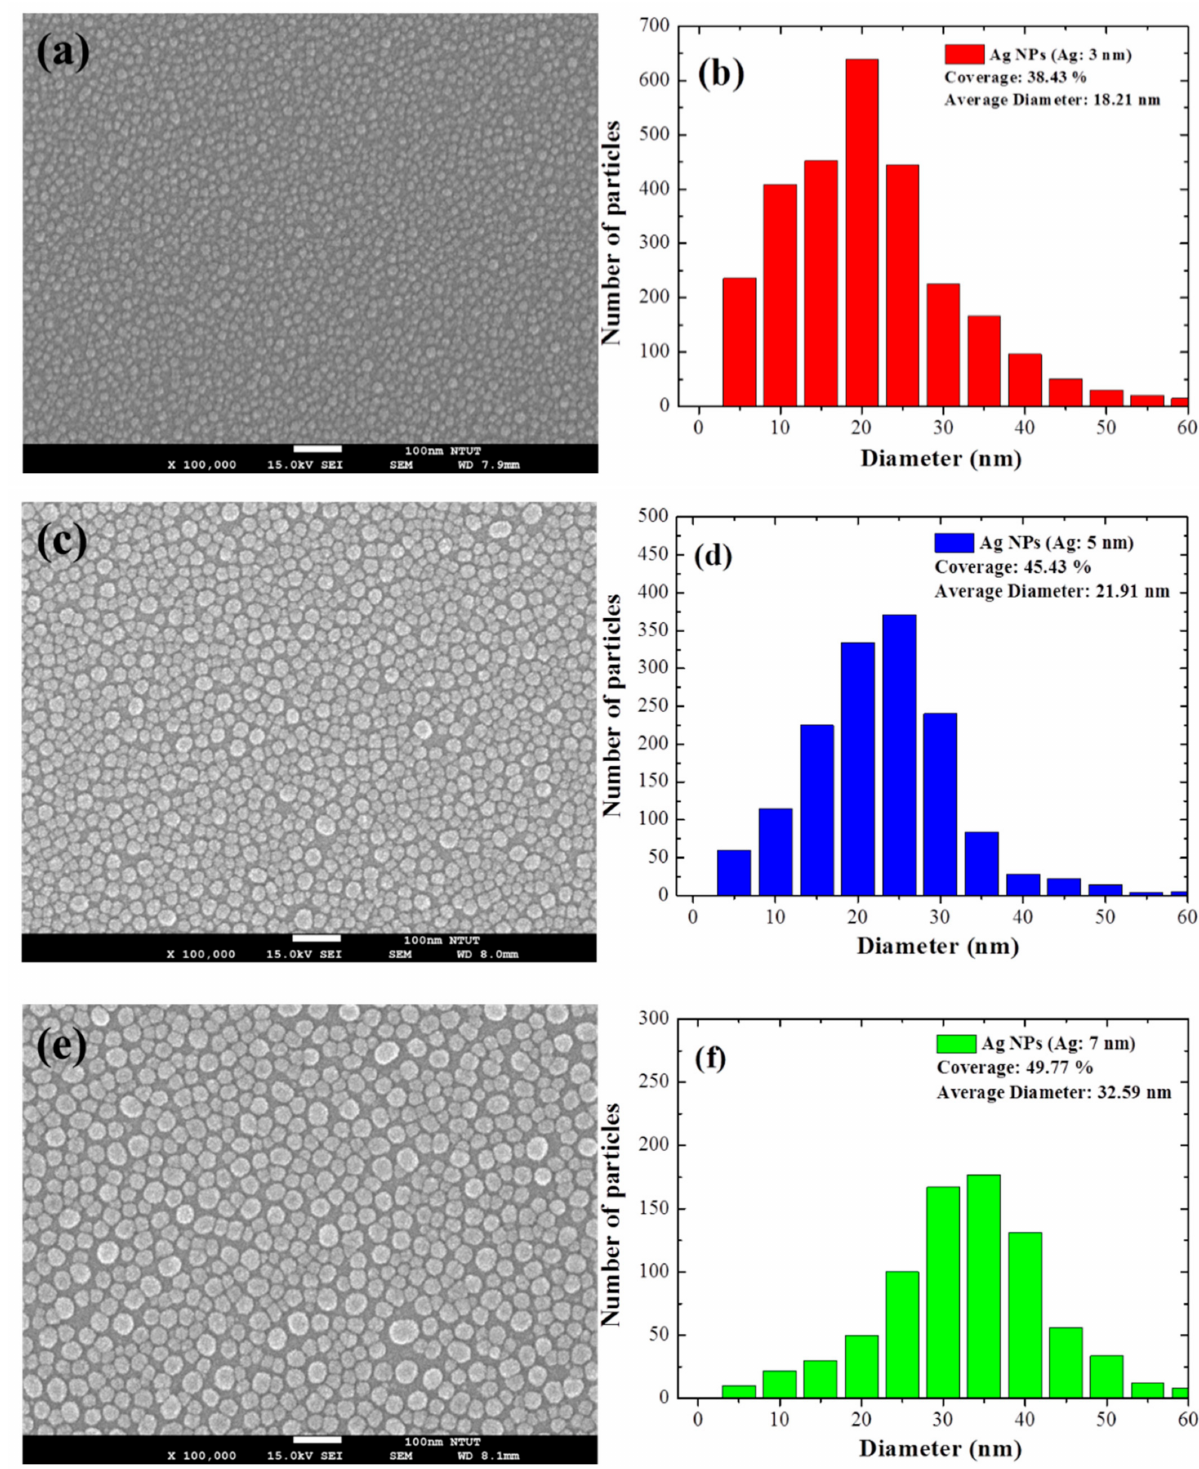
Figure 2. ( a , c , e ) Top view SEM images and ( b , d , f ) size distributions of Ag-NPs in Ag films deposited to thicknesses of 3, 5, and 7